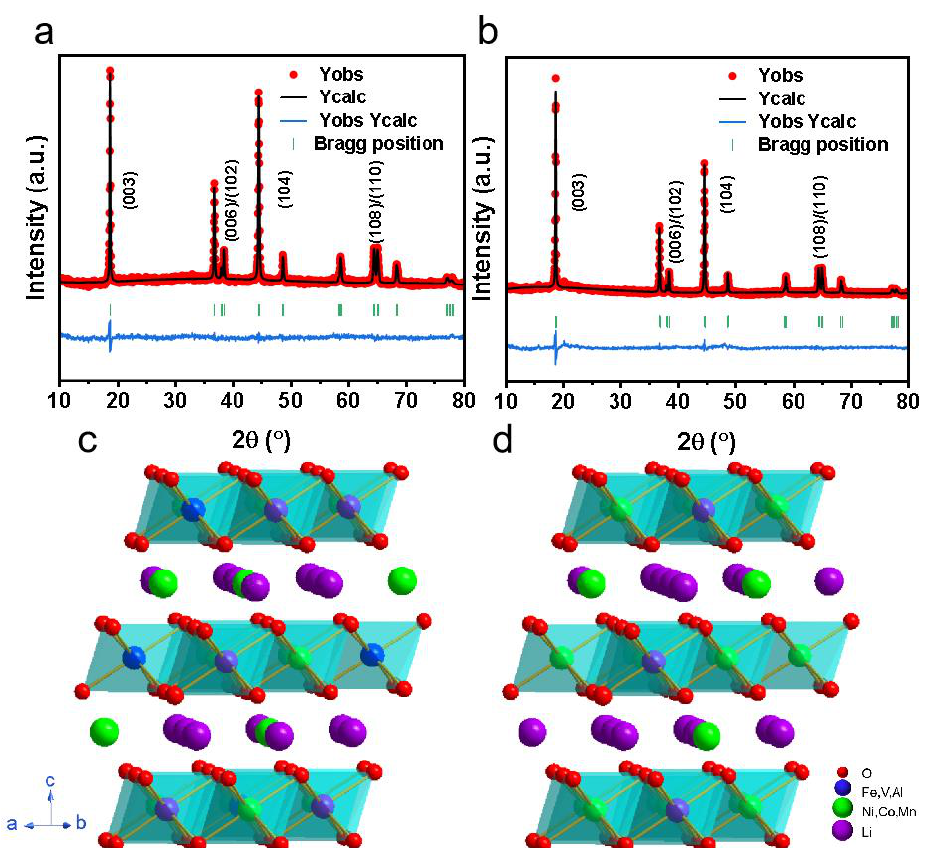
Figure 6. XRD patterns of ( a ) C － NCM and ( b ) S － NCM. Crystal structure diagram of ( c ) C － NCM and ( d ) S － NCM.